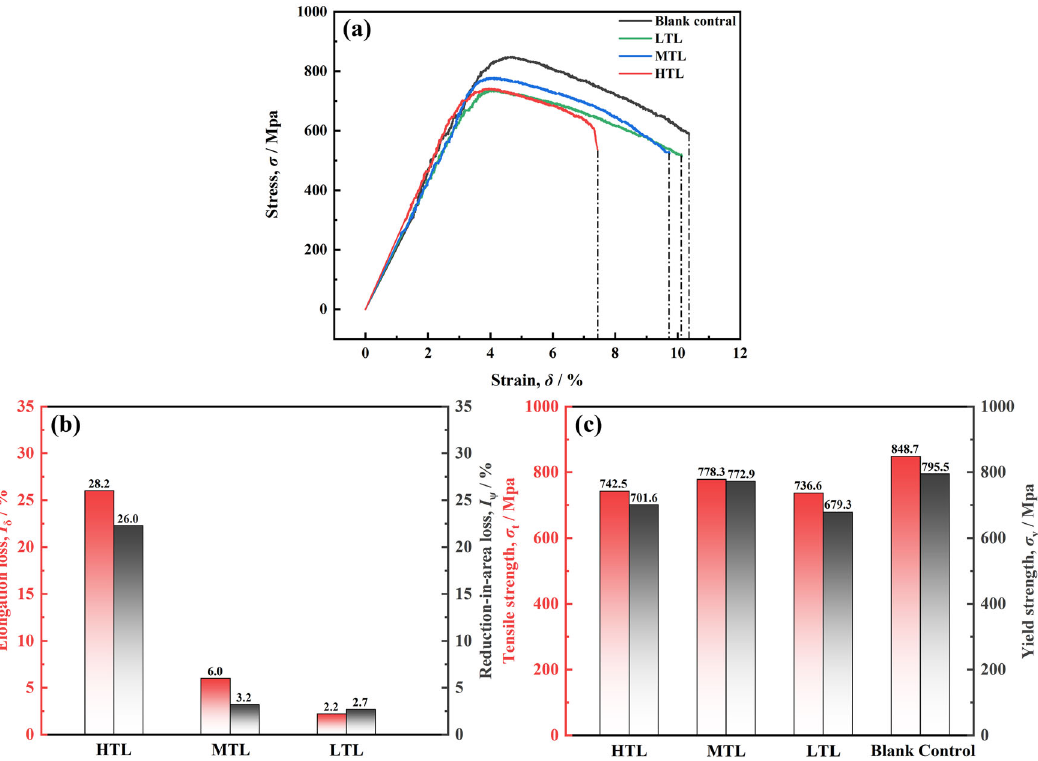
Fig. 10 Results of SSRT for the AISI 4135 steel samples after exposure to the tidal zone for 100 days. a Stress – strain curves, b elongation loss ( I δ ) and reduction-in-area loss ( I ψ ), and c tensile strength ( σ t ) and yield strength ( σ y necked region of the fracture were identi fi ed as shear bands (Fig. 11c6, d6) since they were oriented 45° to the tensile stress direction and parallel to the maximum shear stress direction.